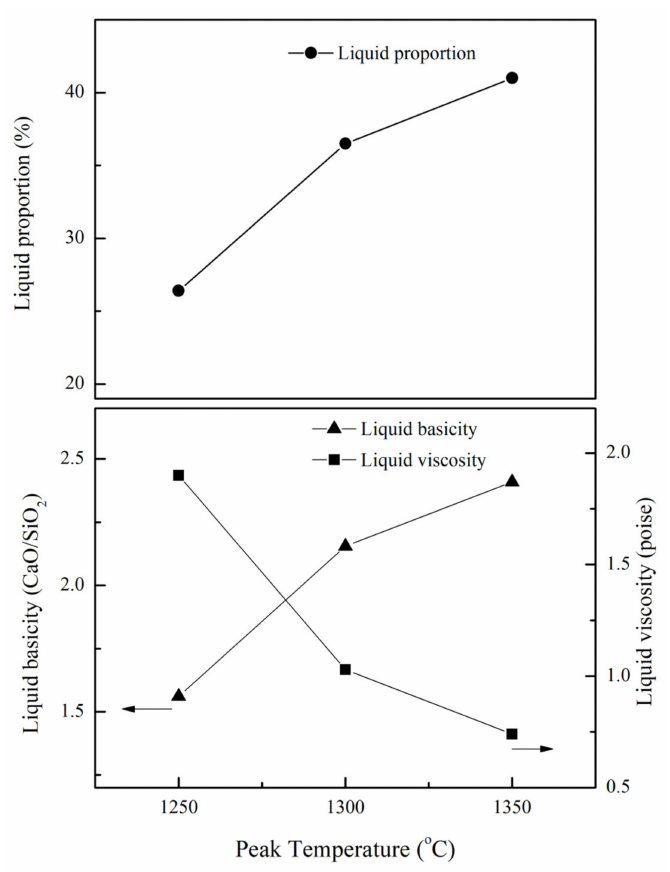
Figure 5. Variation of sinter liquid properties with varied reheating